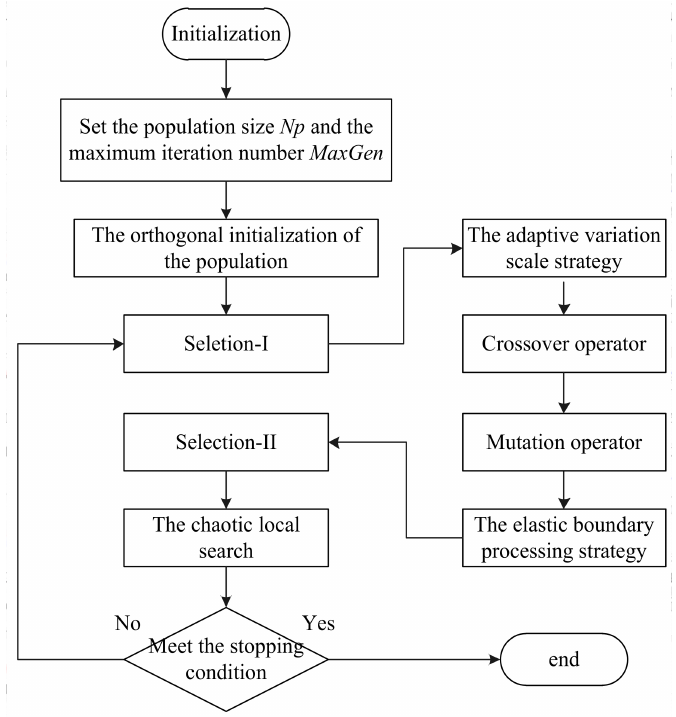
Figure 5. The flowchart of the improved backtracking search